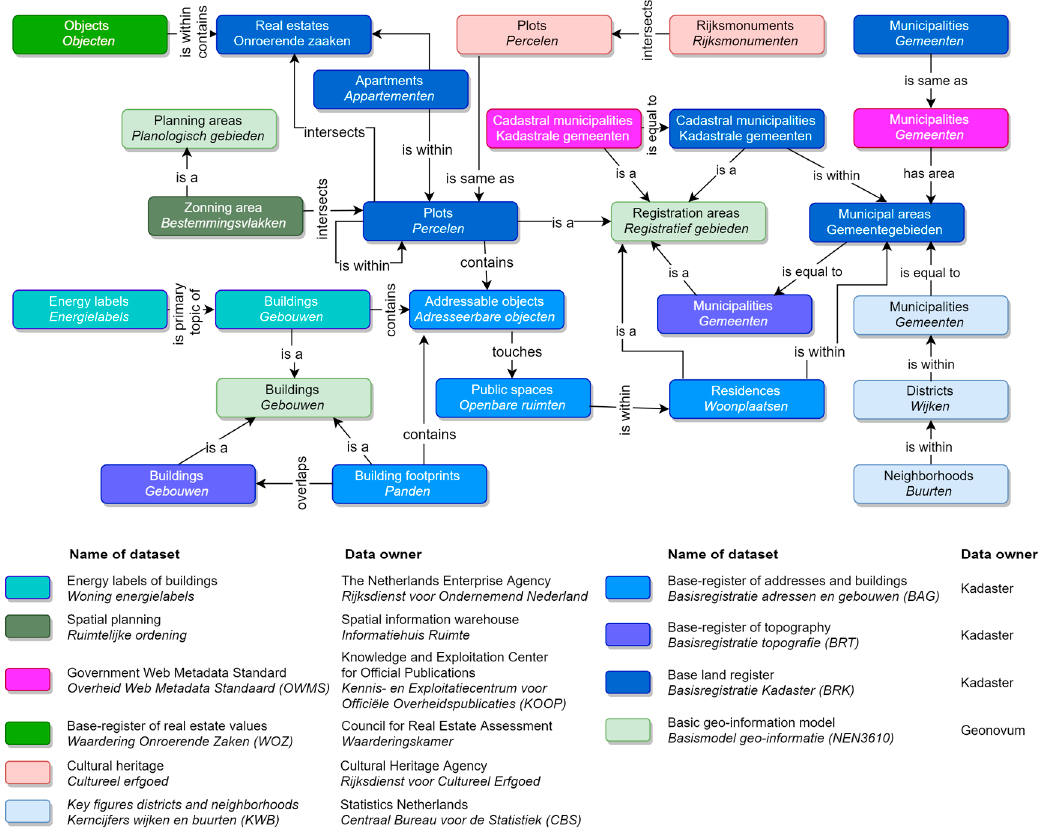
Figure 4. Network diagram of classes and relations comprising the KKG. Rounded rectangles represent classes with colors representing origin of concepts. (Source: authors).